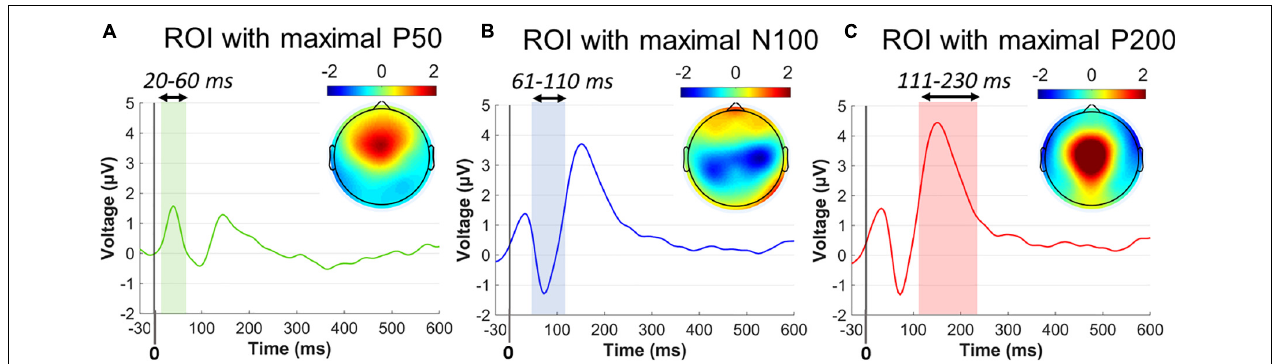
FIGURE 3 | Collapsed ERP waveforms in three ROIs during –30 to 600 ms. (A) ERP wave for the P50 ROI and the P50 topographical distribution averaged across 20–60 ms poststartle. (B) ERP wave for the N100 ROI and the N100 topographical distribution averaged across 61–110 ms poststartle. (C) ERP wave for the P200 ROI and the P200 topographical distribution averaged across 111–230 ms poststartle. Color-shaded areas indicated the window elicitation of the aforementioned ERP components. Time 0 corresponds to the startle onset.